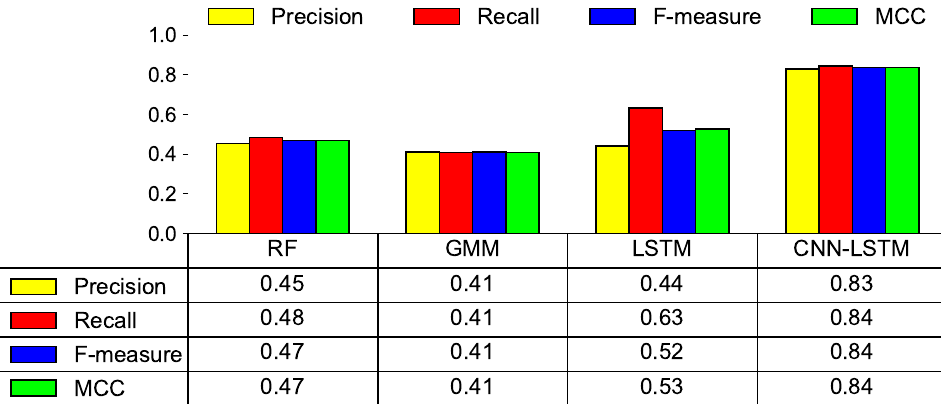
Figure 9. Model prediction results using various performance metrics when FAR = 0.1%.